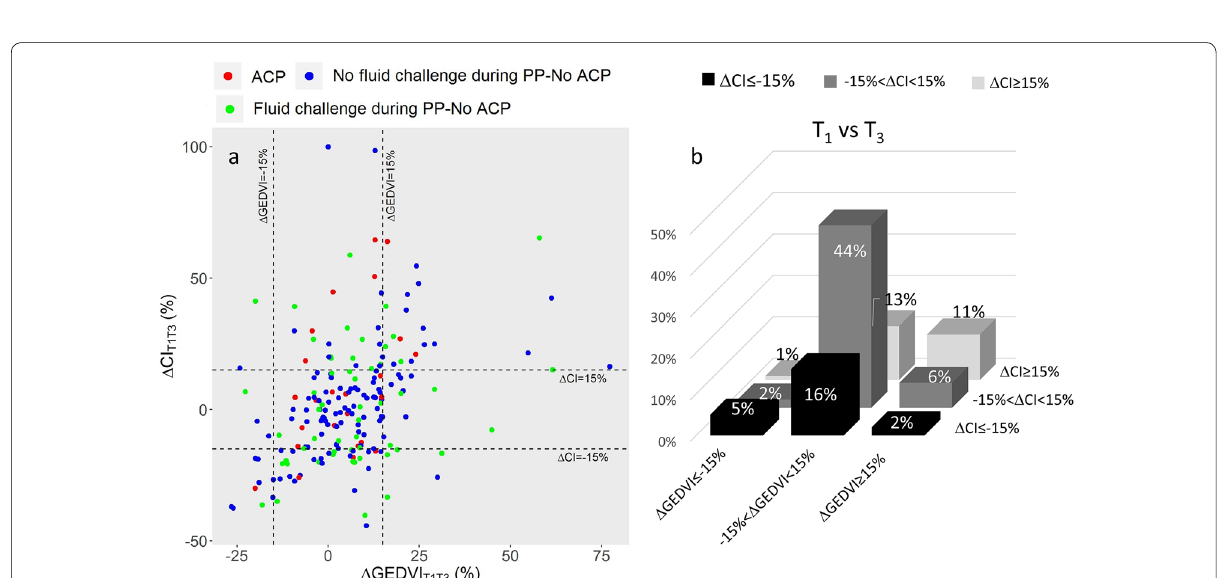
Fig. 3 Hemodynamic pattern as a function of ΔCI and ΔGEDVI between T 1 and T 3 . a Symbols are individual values for each prone position session. Broken lines are threshold values for significant changes in CI ( refer to patients without ACP and without fluid challenge between T 1 and T 3 . Green dots refer to patients without ACP and with any fluid challenge between T 1 and T 3 . b Bars are percentage of patients falling in each category. CI, cardiac index; GEDVI, global end‑diastolic volume index; ACP, acute cor pulmonale; ΔCI, change in CI; ΔGEDVI, change in GEDVI; PP, prone position; T 1 , before prone position; T 3 , end of prone position